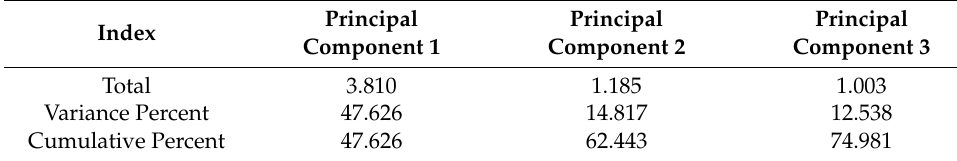
Table 4. The result of PCA.